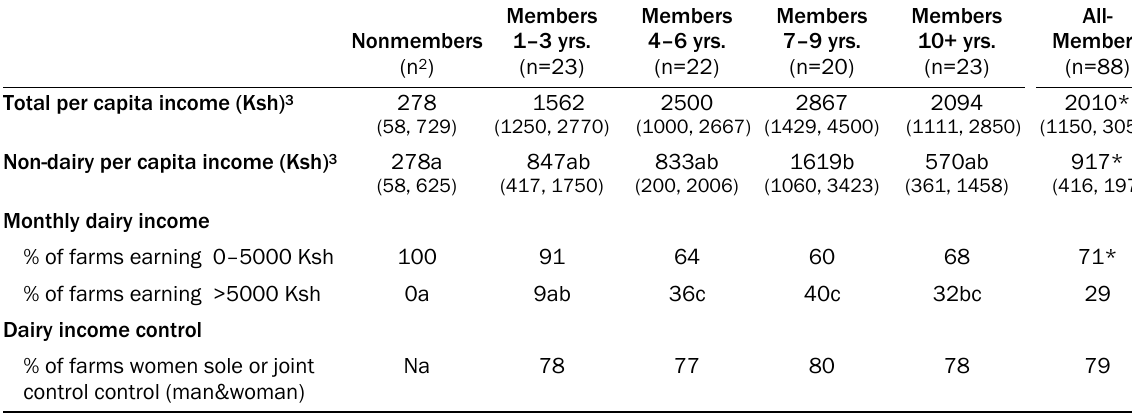
Table 6. Monthly Income and Income Control by Dairy Group Membership Duration